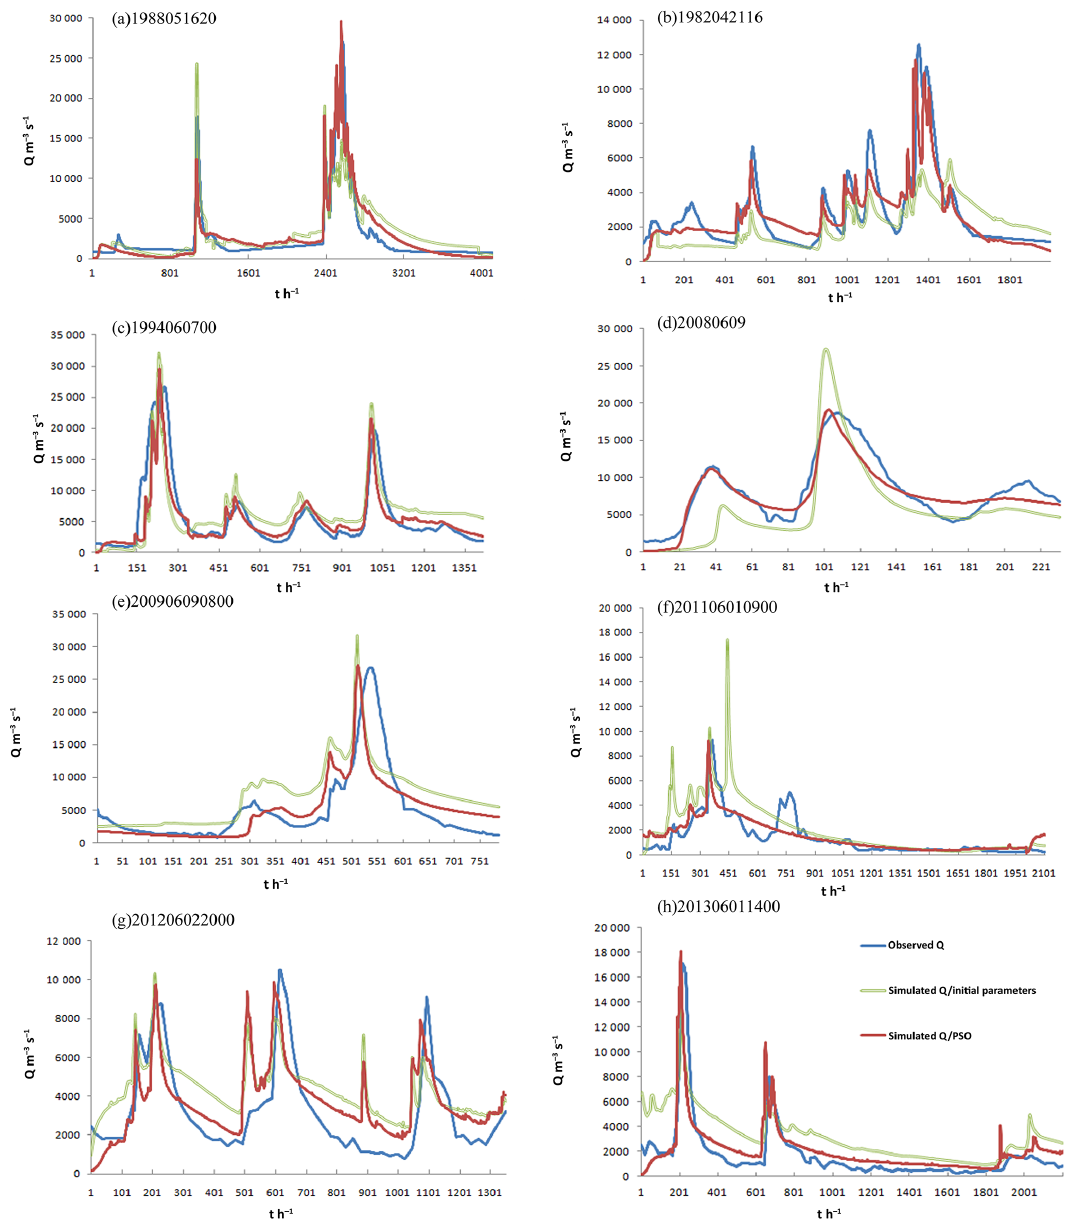
Figure 5. Simulated flood events by Liuxihe model with optimized